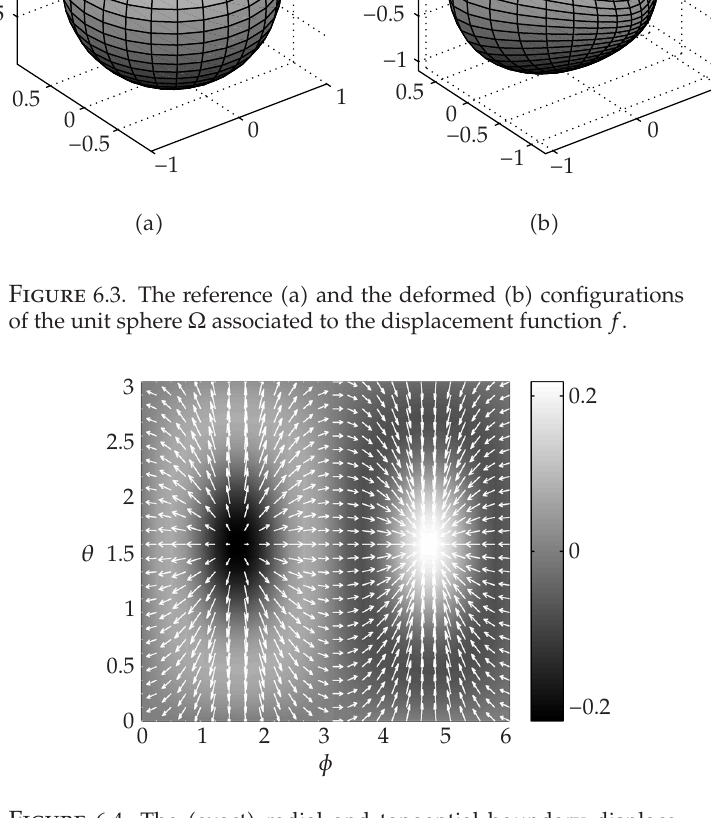
Figure 6.4 . The ( exact ) radial and tangential boundary displace- ments on the unit sphere Ω